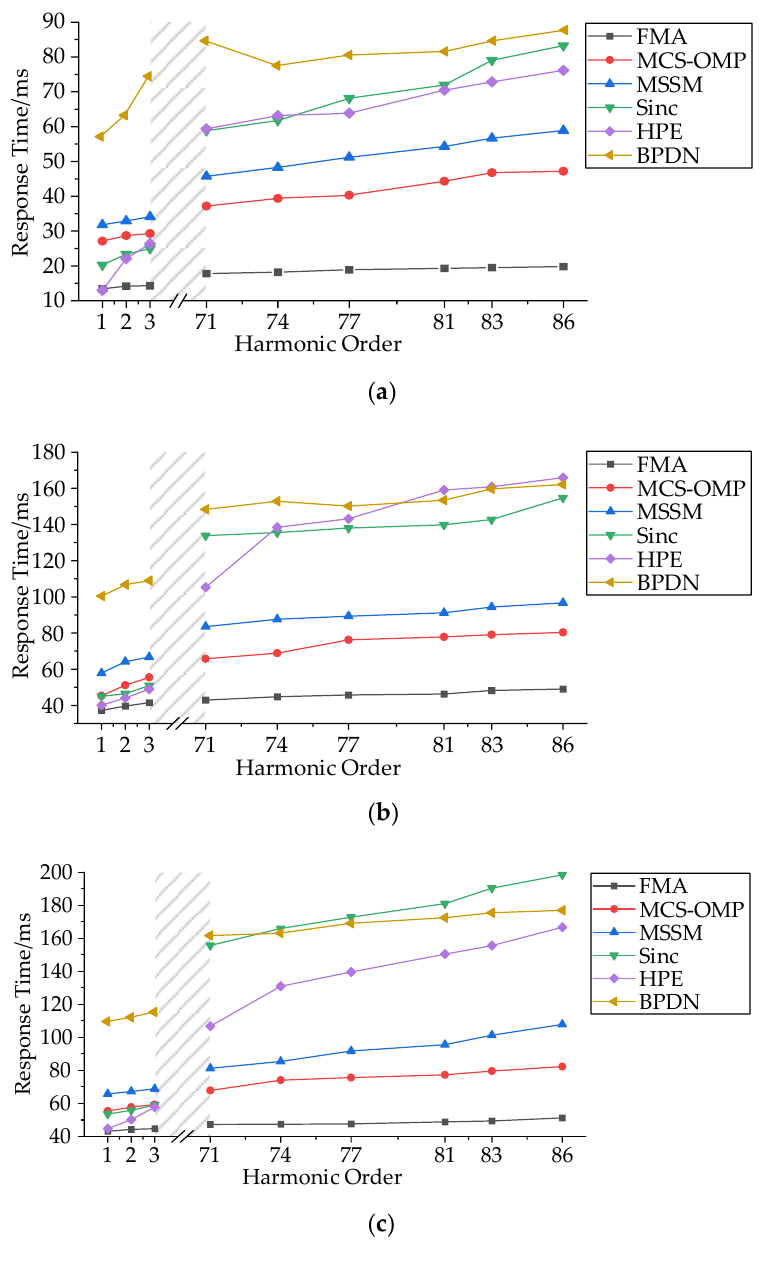
Figure 7. Step-change test results: ( a ) Response time when the TVE of the algorithm analysis result reached 2%; ( b ) Response time when the FE of the algorithm analysis result reached 0.14 Hz; ( c ) Response time when the RFE of the algorithm analysis result reached 1.6 Hz/s.